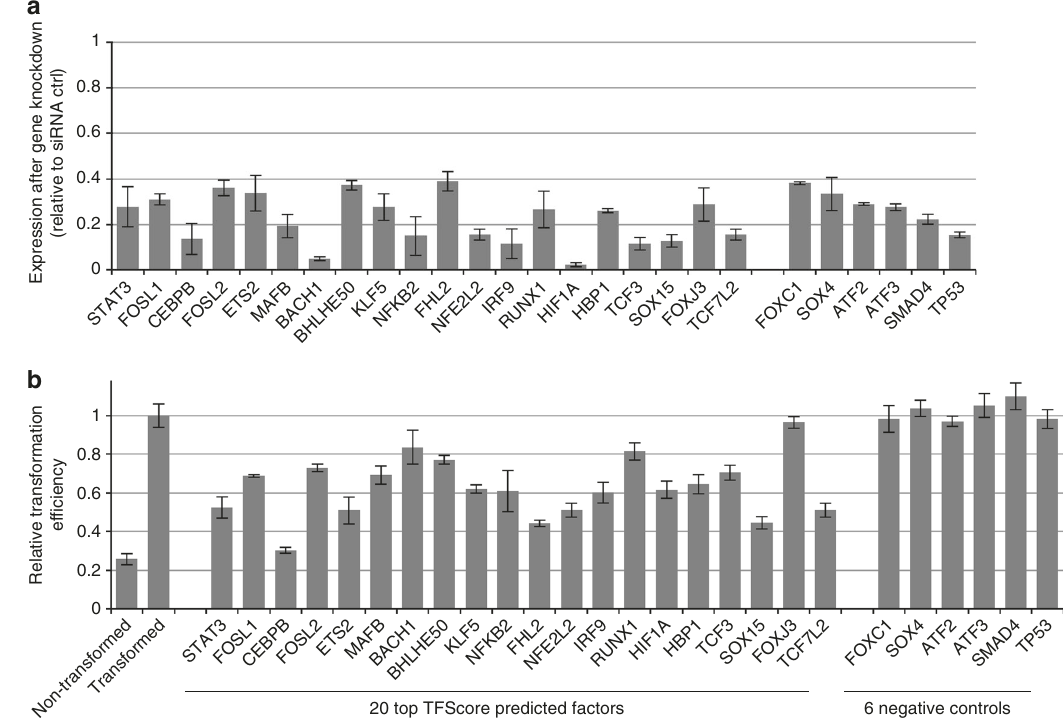
Fig. 5 TFScore-predicted transcription factors are important for transformation. a siRNA knockdown ef fi ciencies of the indicated transcription factors as compared to siRNA controls. b Relative transformation ef fi ciency of the indicated transcription factors as determined by their ability to grown under low attachment